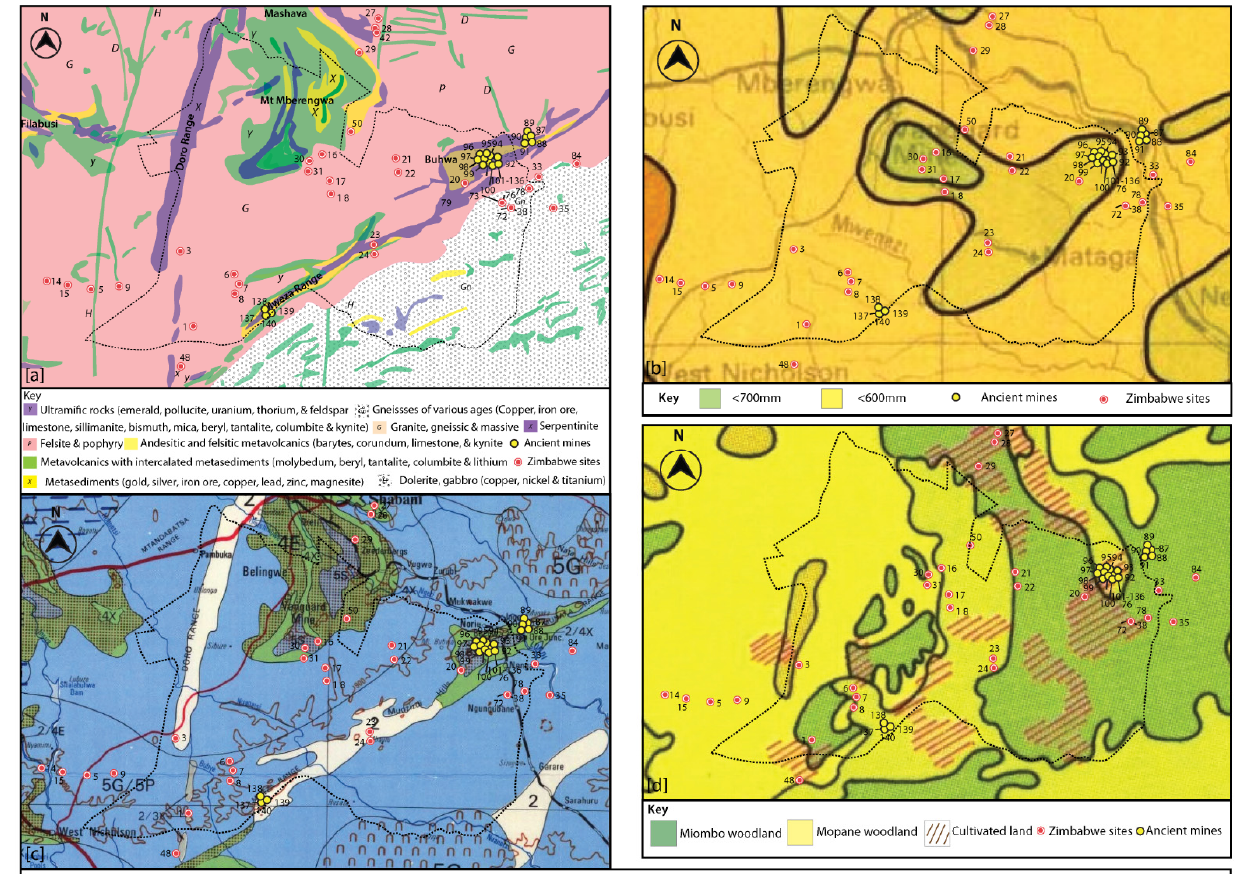
Figure 3. Bio-physiographic maps of the landscape in and around Mberengwa showing the distribution of Zimbabwe tradition sites and ancient mines in relation to the ( a ) geology (adapted from [55]); ( b ) mean annual rainfall patterns (adapted from [56]); ( c ) soil classes (adapted from [57]); and ( d ) vegetation types (adapted from